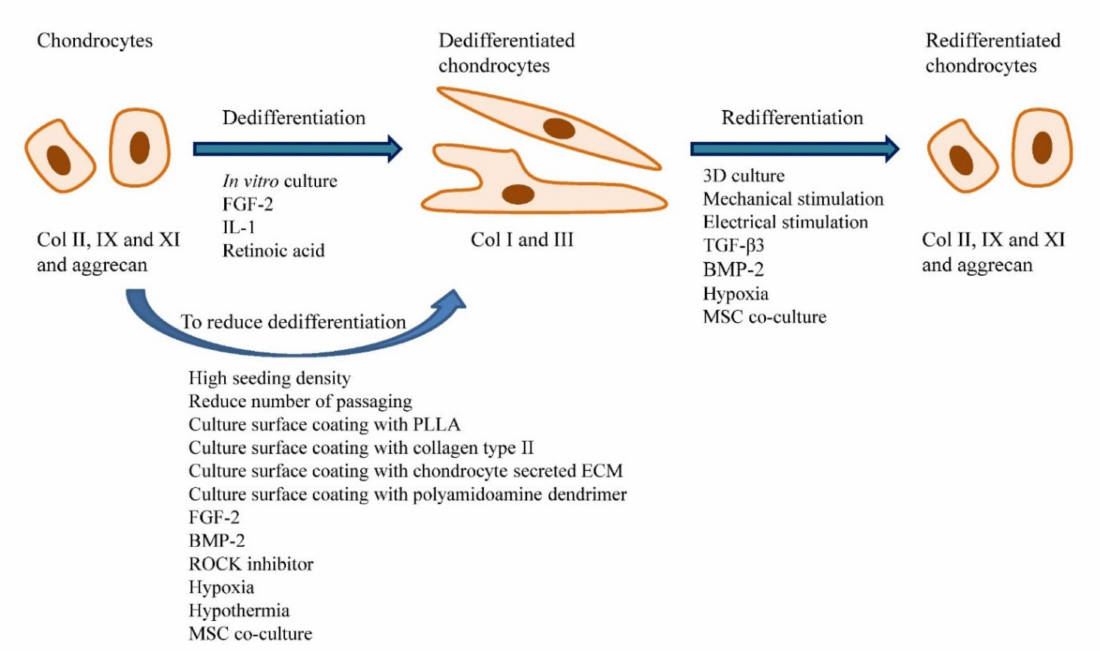
Figure 2. Factors that affect chondrocyte dedifferentiation and redifferentiation in vitro. Chondrocytes cultured in vitro will become dedifferentiated and the process is accelerated in the presence of FGF-2, IL-1 and retinoic acid. Strategies such as seeding the cells at high density, reduce frequency of passaging, culture surface coating with specific substrates (i.e., PLLA, collagen type II, chondrocyte secreted ECM and polyamidoamine dendrimer), addition of specific chemicals (i.e., FGF-2, BMP-2 and ROCK inhibitor), cell culture at low oxygen tension and low temperature, and co-culture with MSCs can reduce chondrocytes dedifferentiation. The dedifferentiated chondrocytes can be redifferentiated through 3D cell culture, application of mechanical and electrical stimulus, addition of certain chemicals (i.e., TGF- β 1 and BMP-2), hypoxic culture and MSC